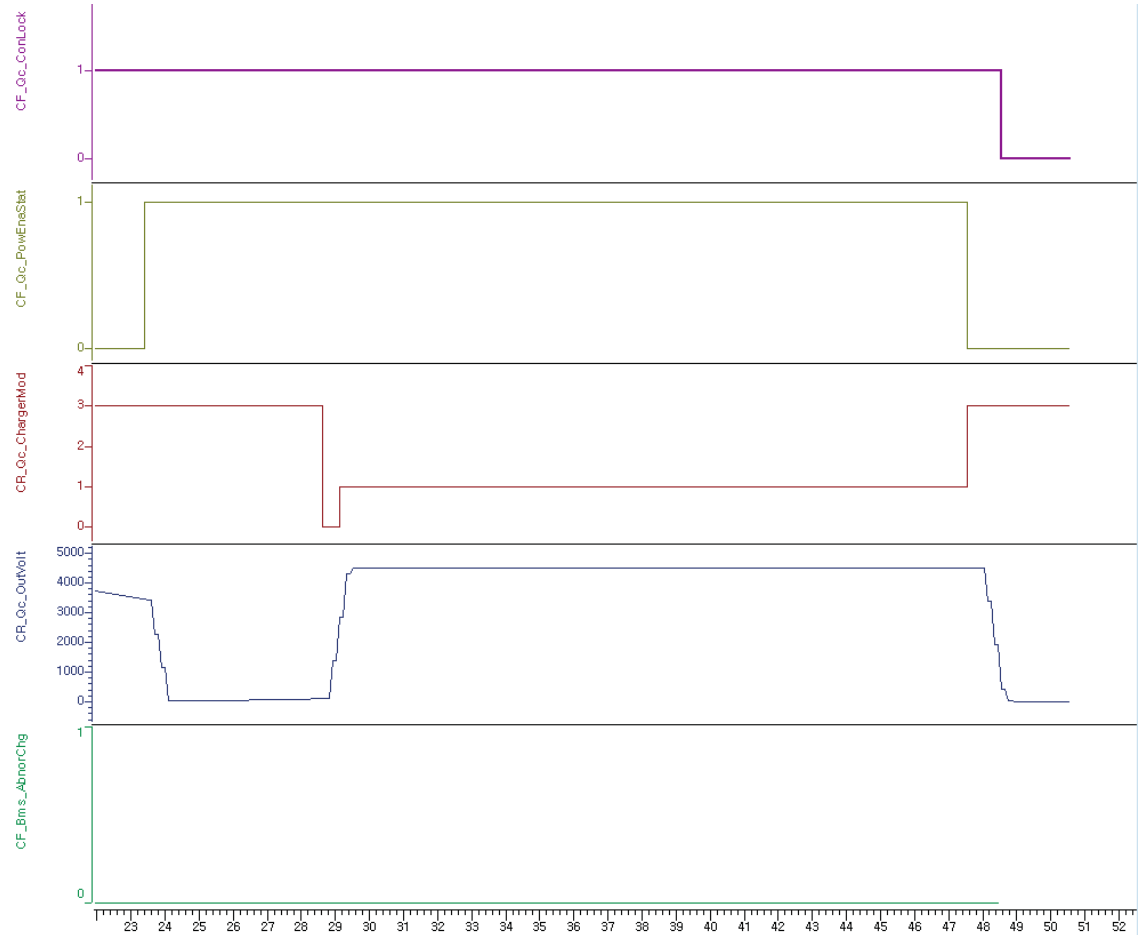
Figure 7. Graphic window in CANoe after successfully testing the normal charging